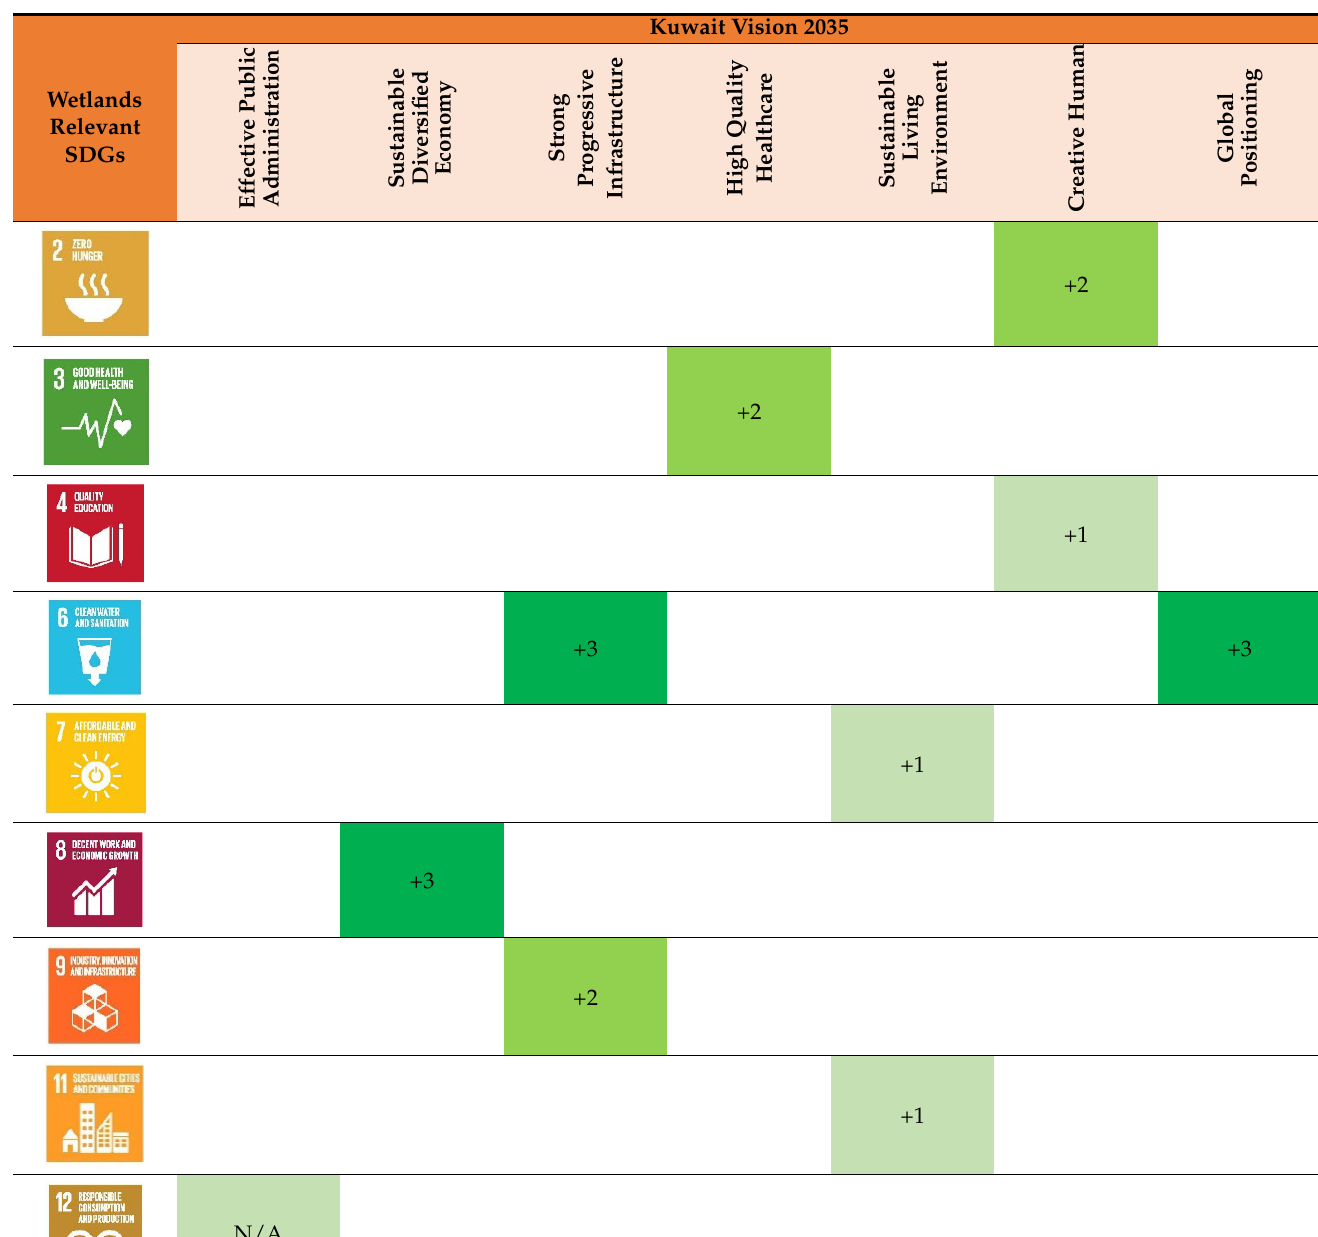
Table 5. The synergies between the Kuwait (Vision 2035) targets and their relevant